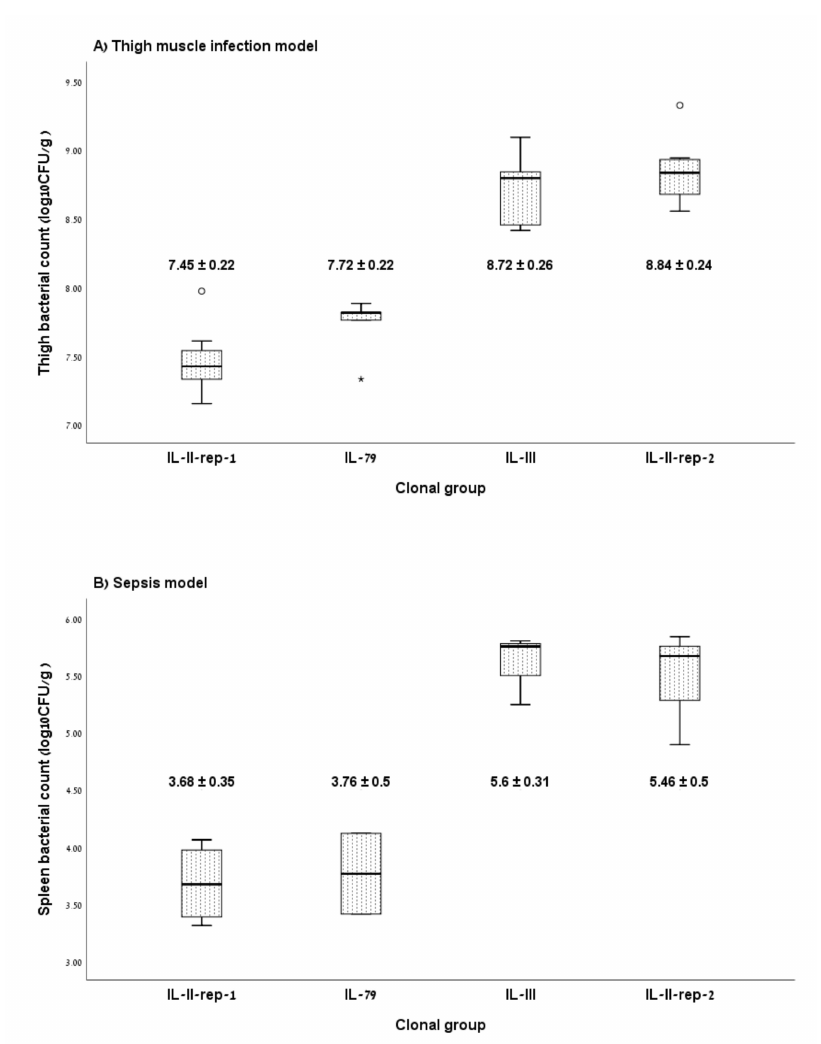
Figure 2. E ff ect of clonal group on in vivo fitness. Bacterial counts in thigh muscle ( A ) and spleen ( B ) following infection with isolates belonging to CRAB clonal groups with low case fatality (IL-II-rep-1 and IL-79) and high case fatality (IL-III and IL-II-rep-2). Box plots depict the median (central horizontal lines), inter-quartile range (boxes) and minimal / maximal values (whiskers). Numerical values are the mean and standard